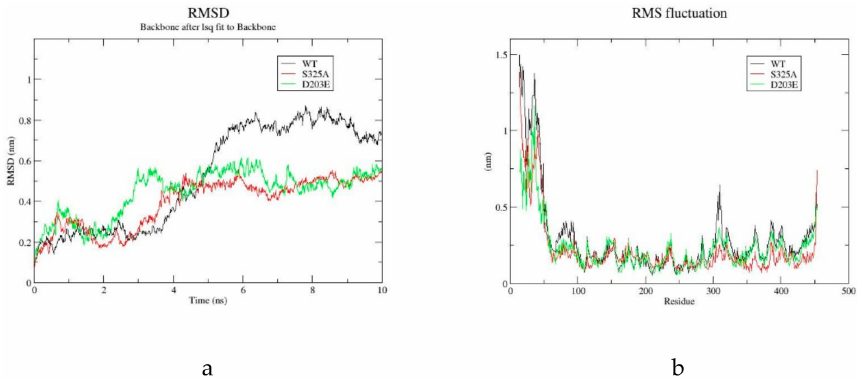
Figure 4. Molecular dynamics (MD) simulation analysis of WT and S325A for 10 ns at 300 K using Gromacs2018.4. ( a ) The root mean square deviation (RMSD) values of WT and its mutants D203E,